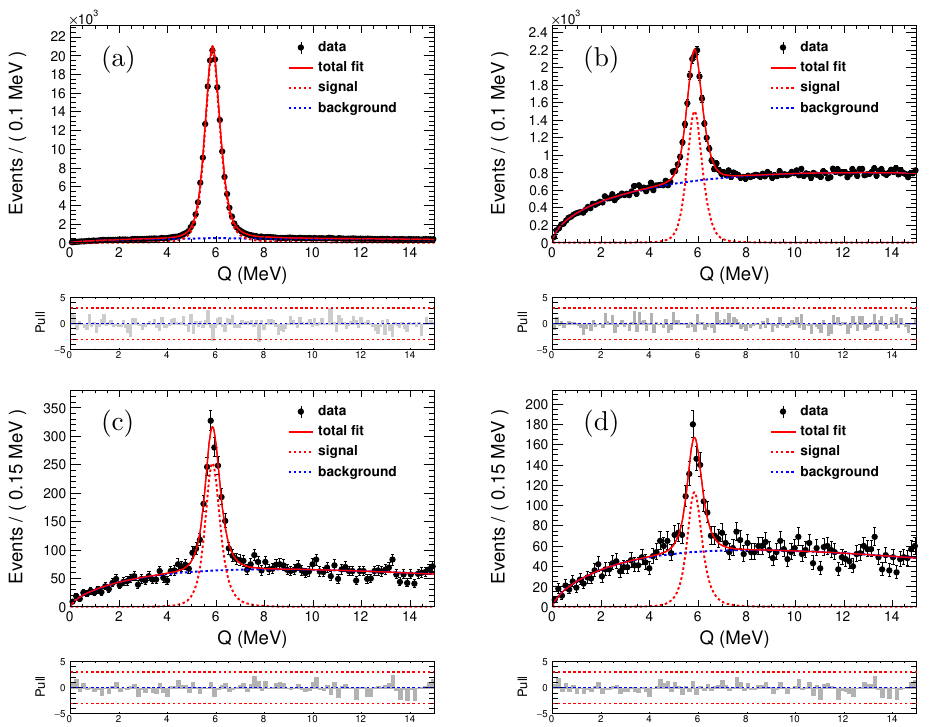
decay for (a) D 0 → K − π + η , (b) s